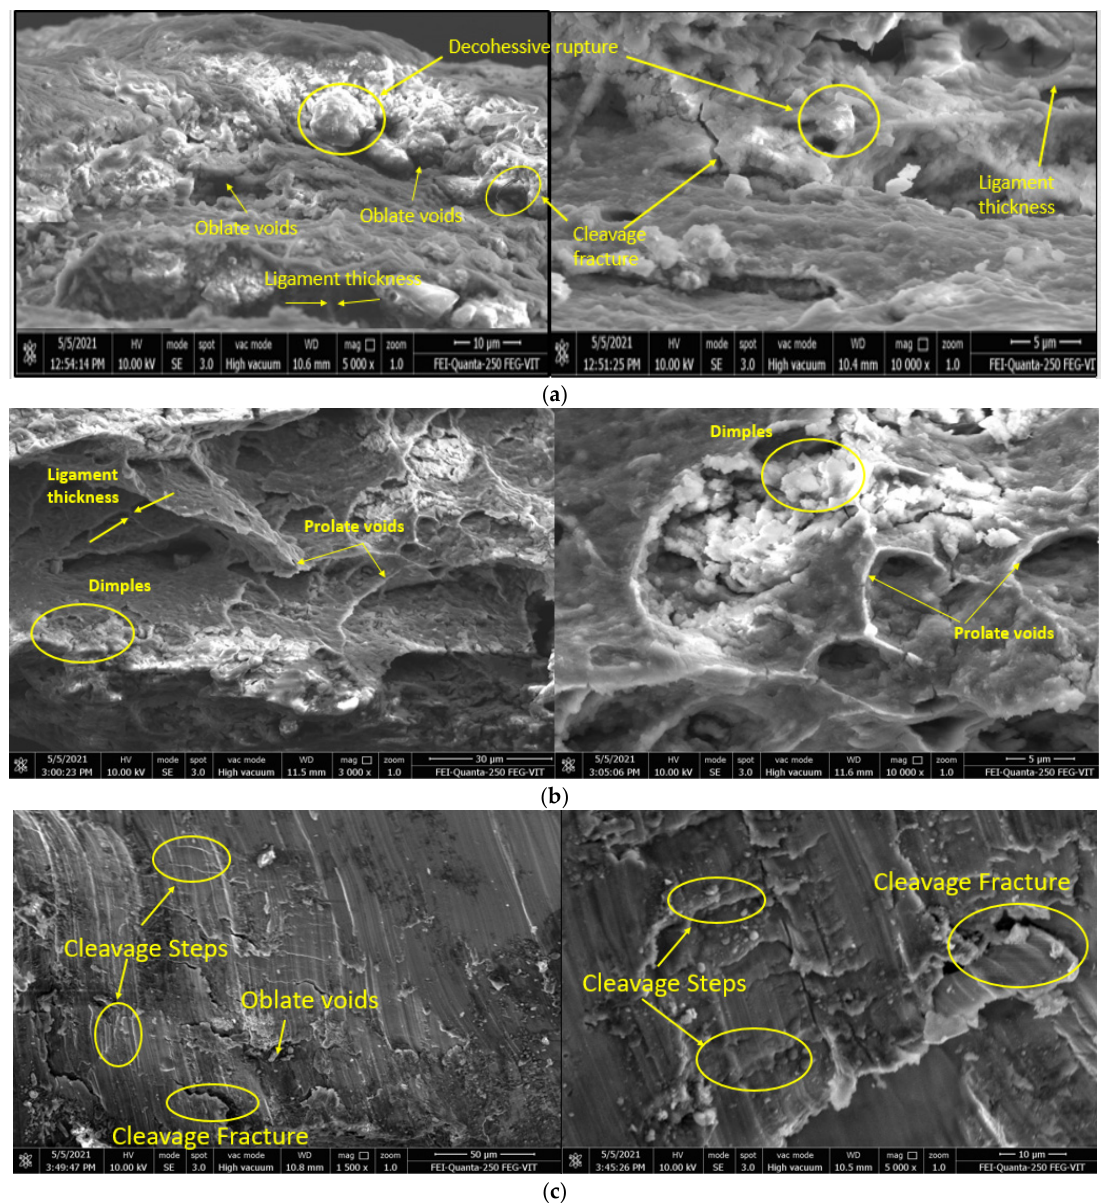
Figure 11. SEM images of a fractured surface of a sample at different magnifications, with ( a ) highest formability, ( b ) medium formability, and ( c ) least formability .